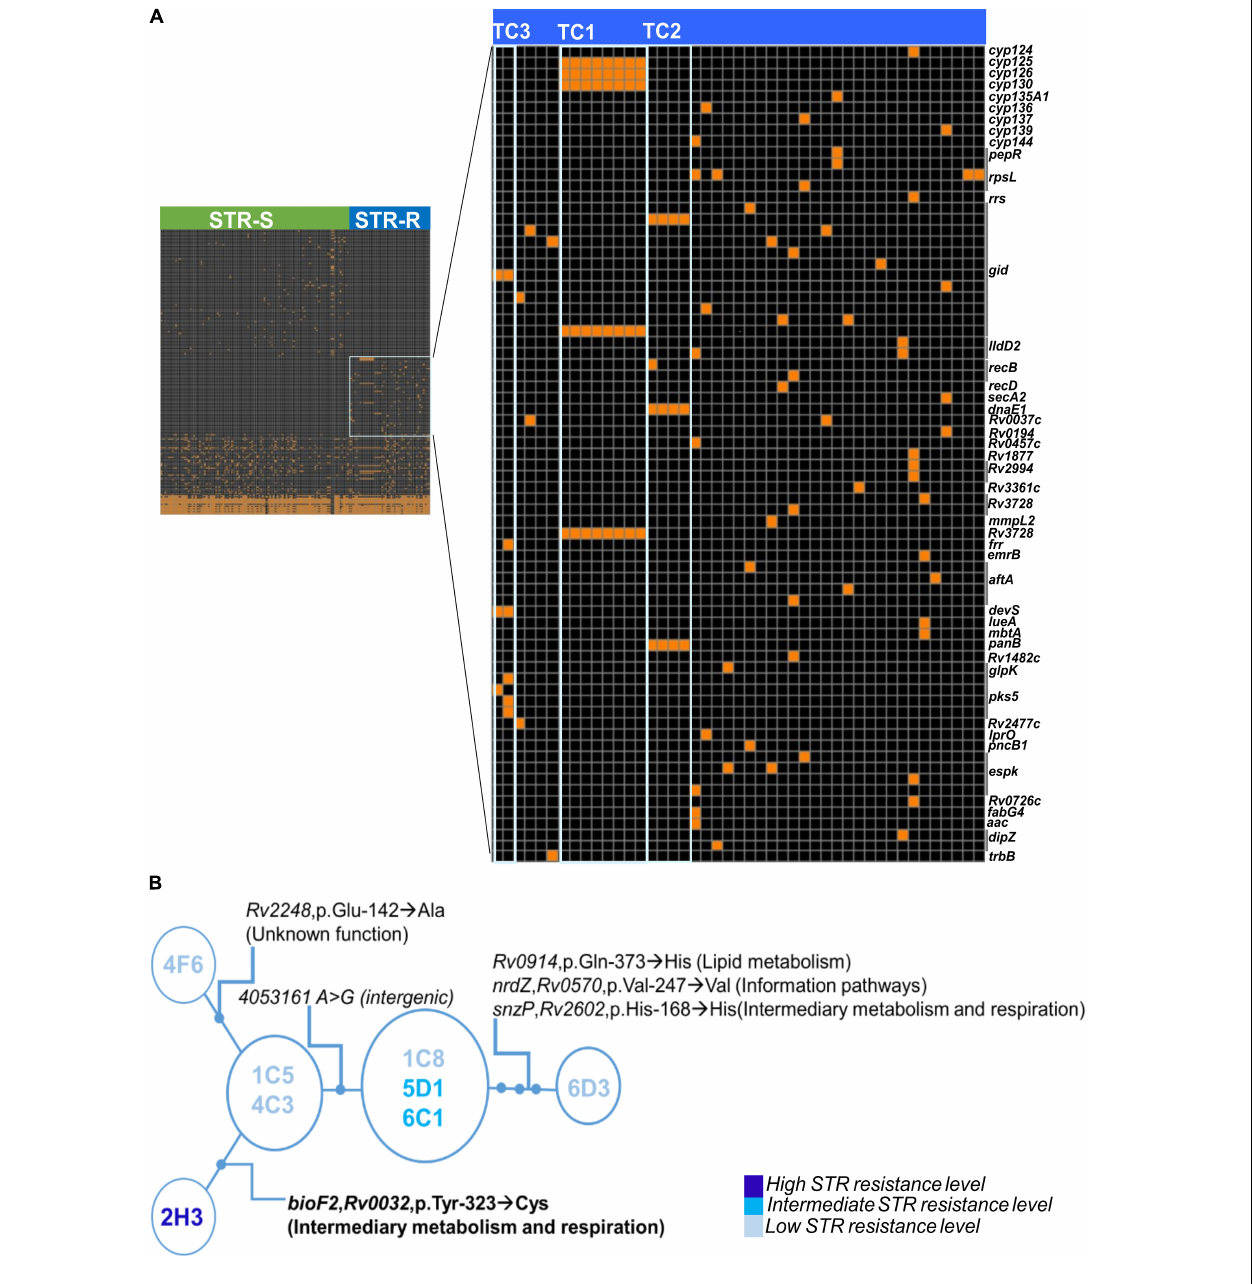
FIGURE 5 | Whole-genome sequencing analysis unveils novel candidate STR resistance mutations. (A) Genome-wide analysis of 149 M. tuberculosis clinical isolates, 104 STR susceptible and 45 STR resistant strains. The header symbolizes the M. tuberculosis isolates, green represent the STR susceptible isolates (STR-S) and blue STR resistant isolates (STR-R). The right axis includes 150 polymorphisms. The black area of the heat map corresponds to the absence of polymorphisms and the orange squares are shown when the polymorphism (SNP or Indel) is found in the different isolates. The area highlighted with a square in light-blue shows the polymorphisms identified exclusively in STR resistant isolates. In the heat map with the STR resistant exclusive polymorphisms, gray line group the polymorphisms presented in the same gene, size of the line depends on the number of SNPs or Indels. Polymorphisms of TC1, TC2, and TC3 are highlighted in the heat map with the light blue boxes. (B) Minimum Spanning Tree Representation of cluster TC1 clinical isolates indicating the polymorphisms separating the nodes and the level of STR resistance of each isolate. SNP = single nucleotide polymorphism and Indels = insertions or